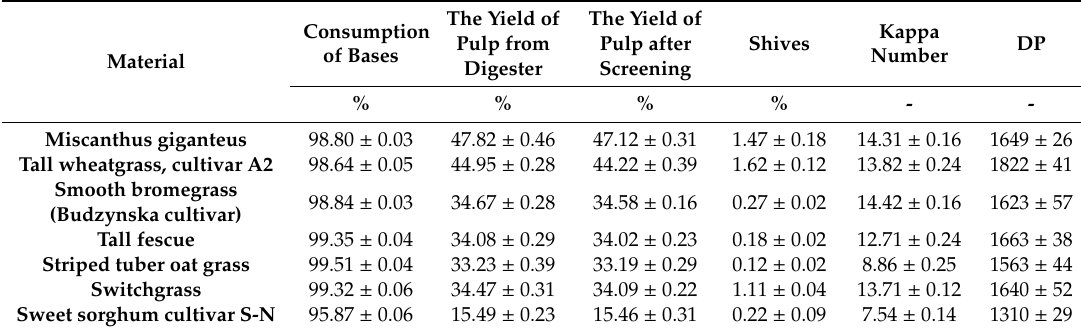
Table 2. Kraft pulping conditions * and characteristics of cellulosic pulps obtained by the sulfate method.